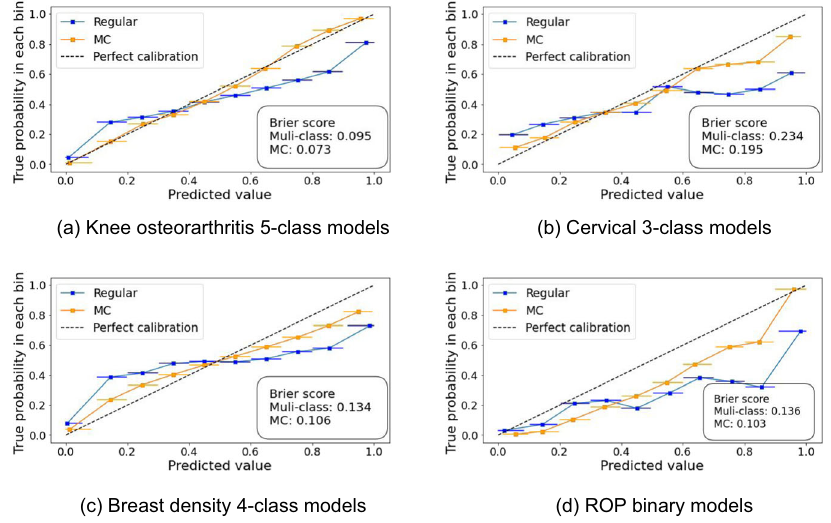
Fig. 6 Calibration curves. ( a ) Knee osteoarthritis 5-class models. ( b ) Cervical 3-class models. ( c ) Breast density 4-class models. ( d ) ROP binary models. Brier score quanti fi es model calibration: 0 indicates a perfectly calibrated model. The horizontal bars represent the predicted value distribution (95% CI) for every